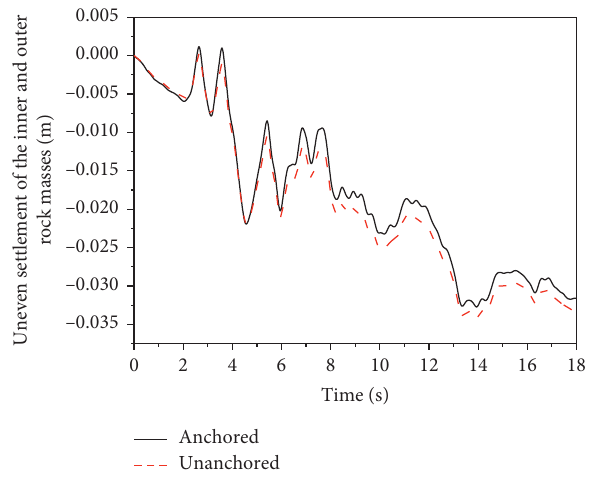
Figure 11: Uneven settlement curves of grottoes with and without